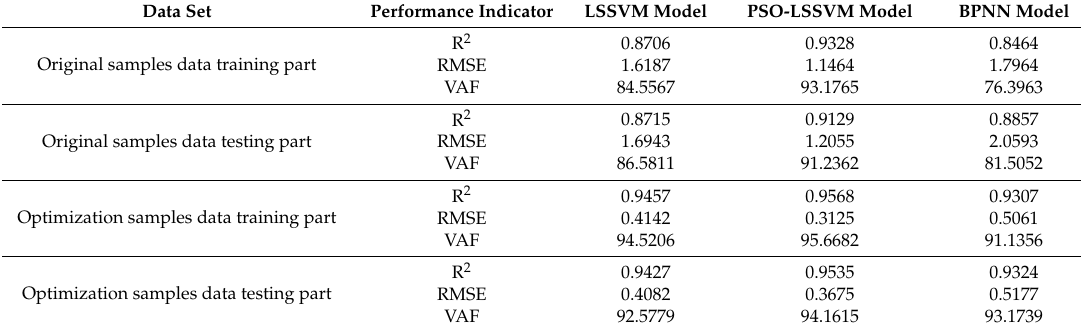
Table 7. Calculated R 2 , RMSE, and VAF indicators of the LSSVM, PSO-LSSVM, and BPNN models.